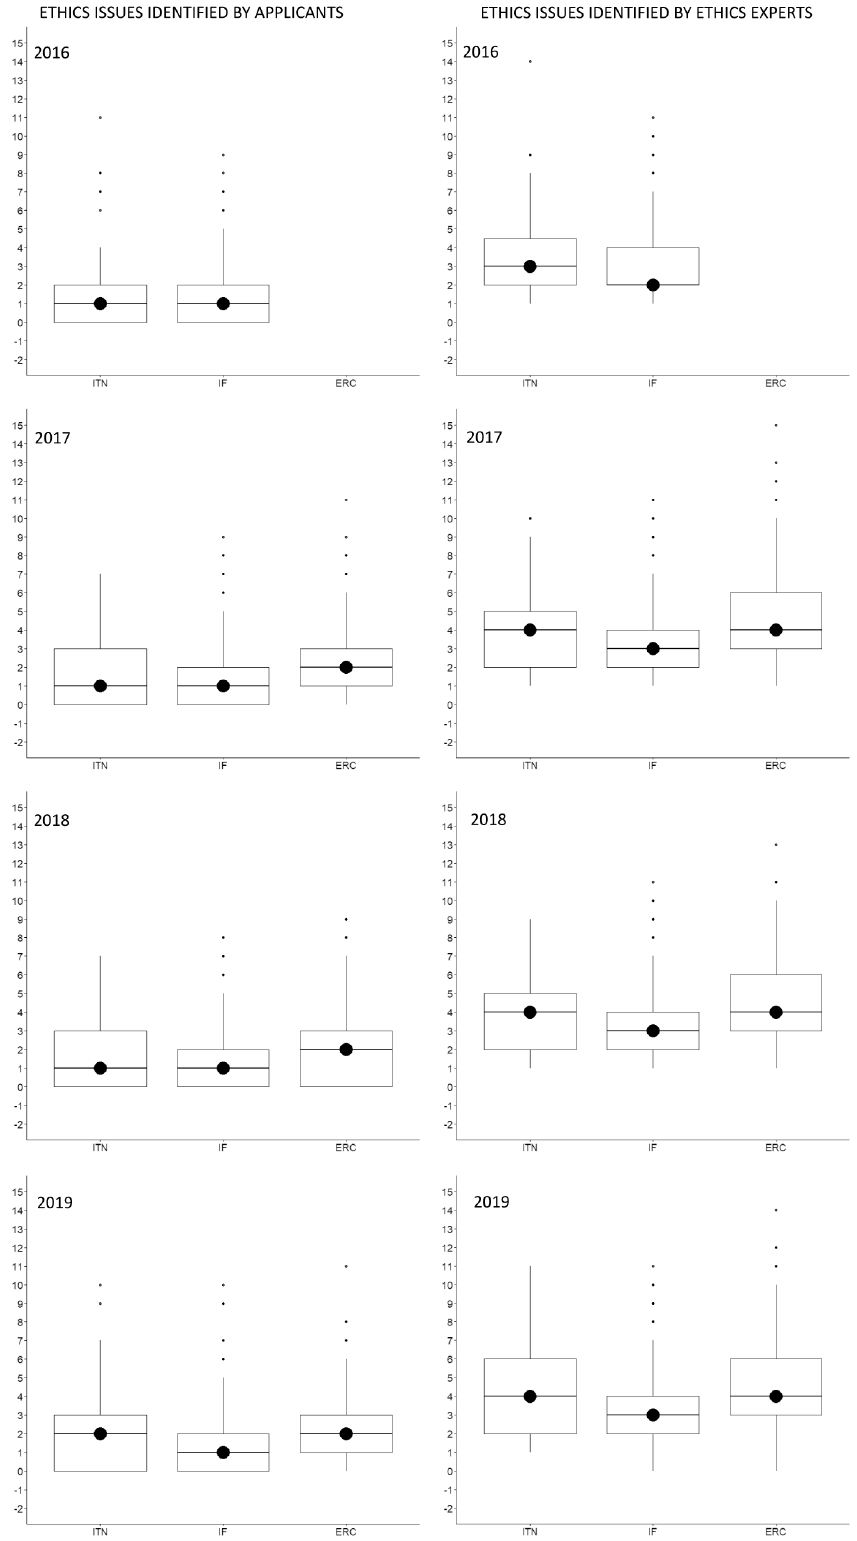
Figure 3. Median number of ethics issues per proposal identified by applicants and by ethics experts, 2016-2019. ITN – Innovative Training Networks, IF – Individual Fellowships, ERC – European Research Council grants. The data are from years available in the SEP tool of the European